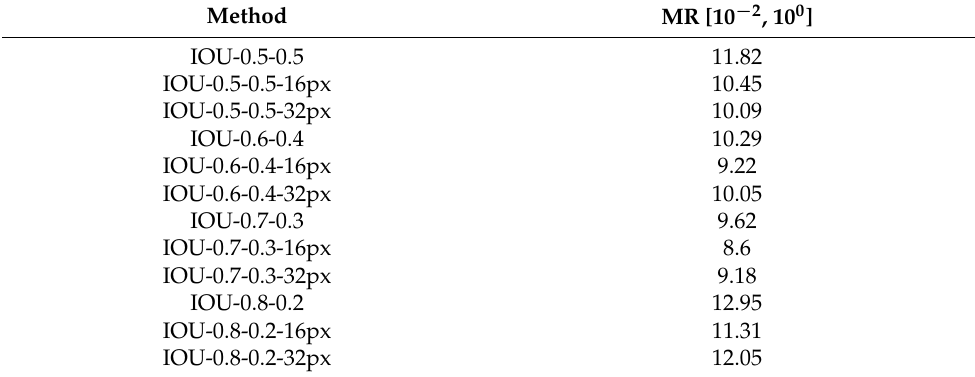
Table 2. Ablation studies on the INRIA